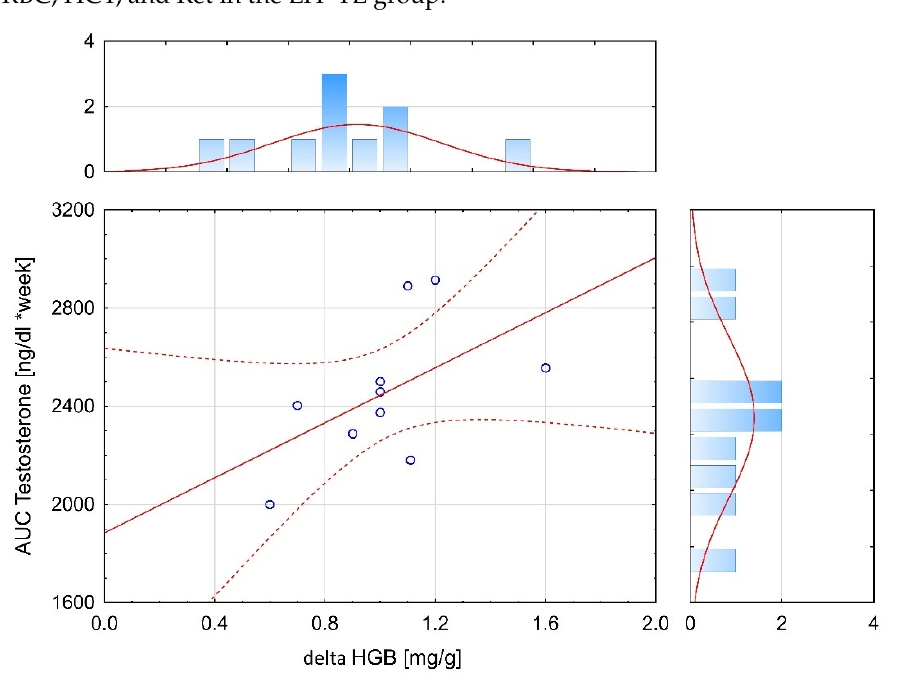
Table 4. Selected hematological variables in the experimental LH–TL group during initial and final evaluations; * p < 0.05, ** p < 0.01—statistically significant differences compared to the baseline values.